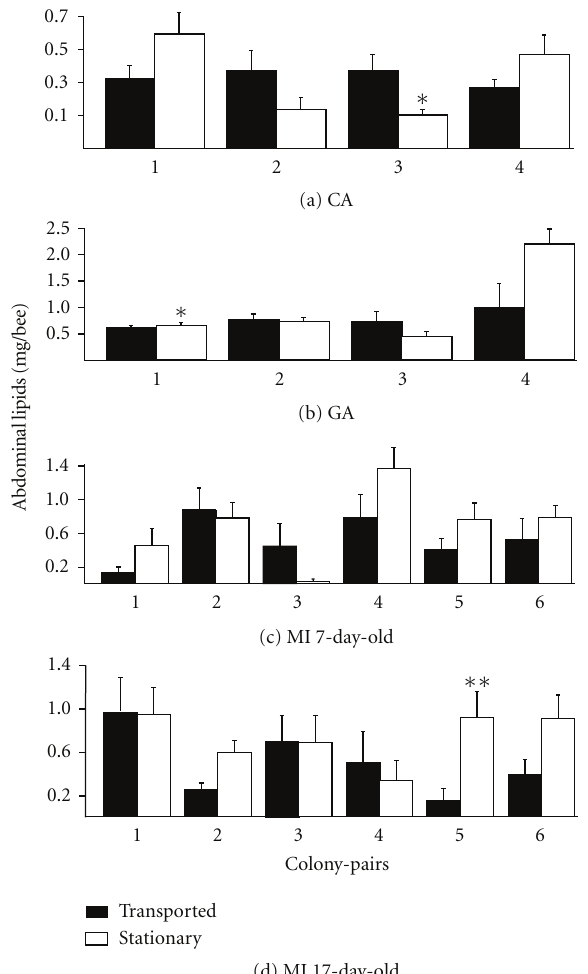
Figure 4: Lipid content (mean ± SE) in worker honey bees experiencing transportation (solid) or no transportation (open) in California (a), Georgia (b), or Michigan ((c), (d)). For more details, see Figure 1